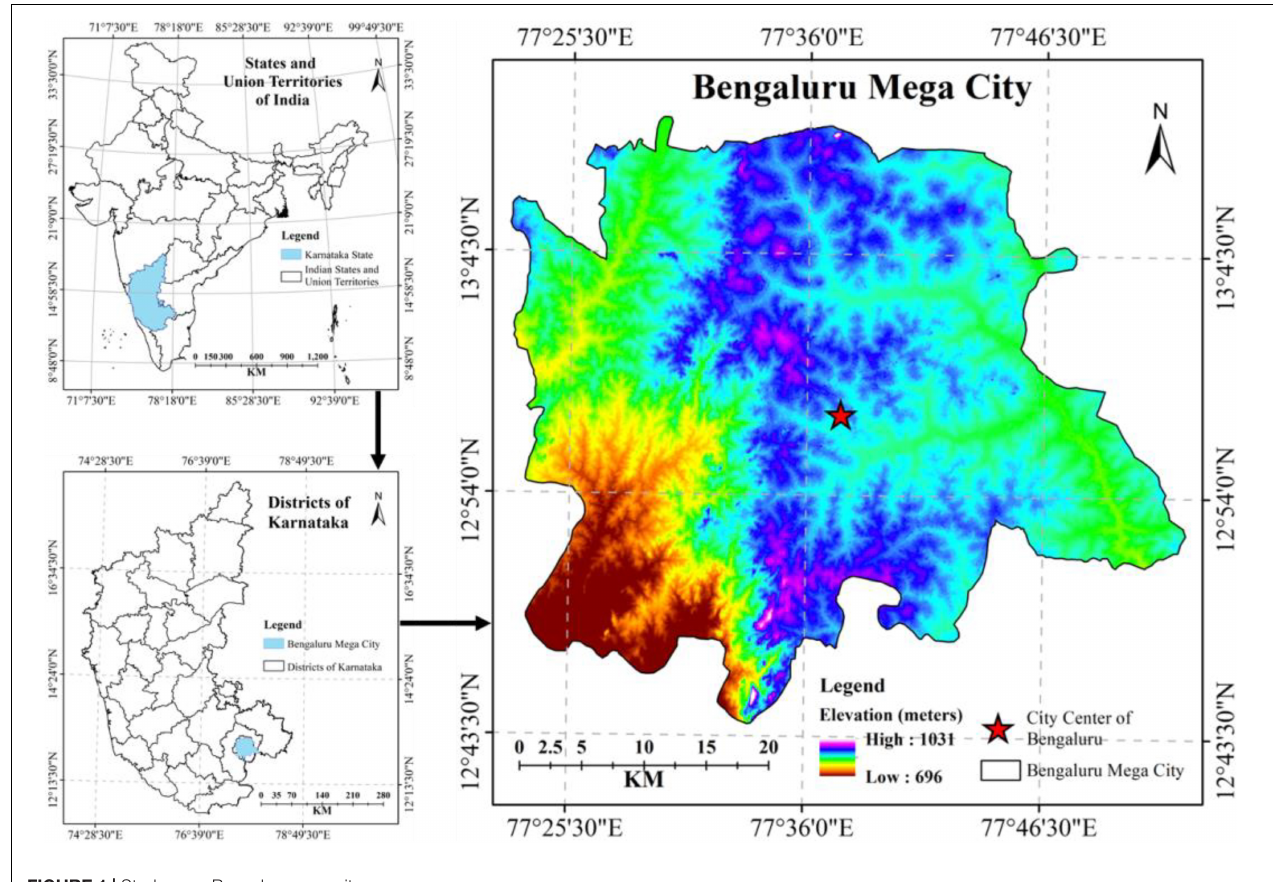
FIGURE 1 | Study area, Bengaluru megacity.